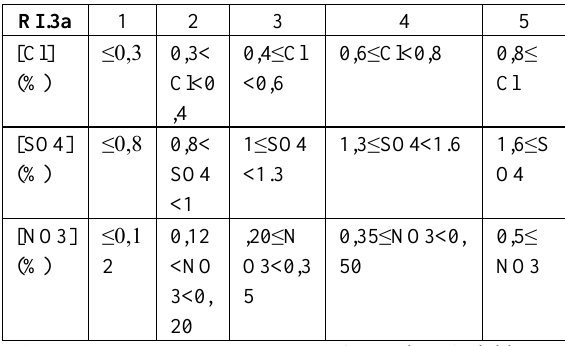
Table 4. Quantitative determination of the anions ‘soluble fraction